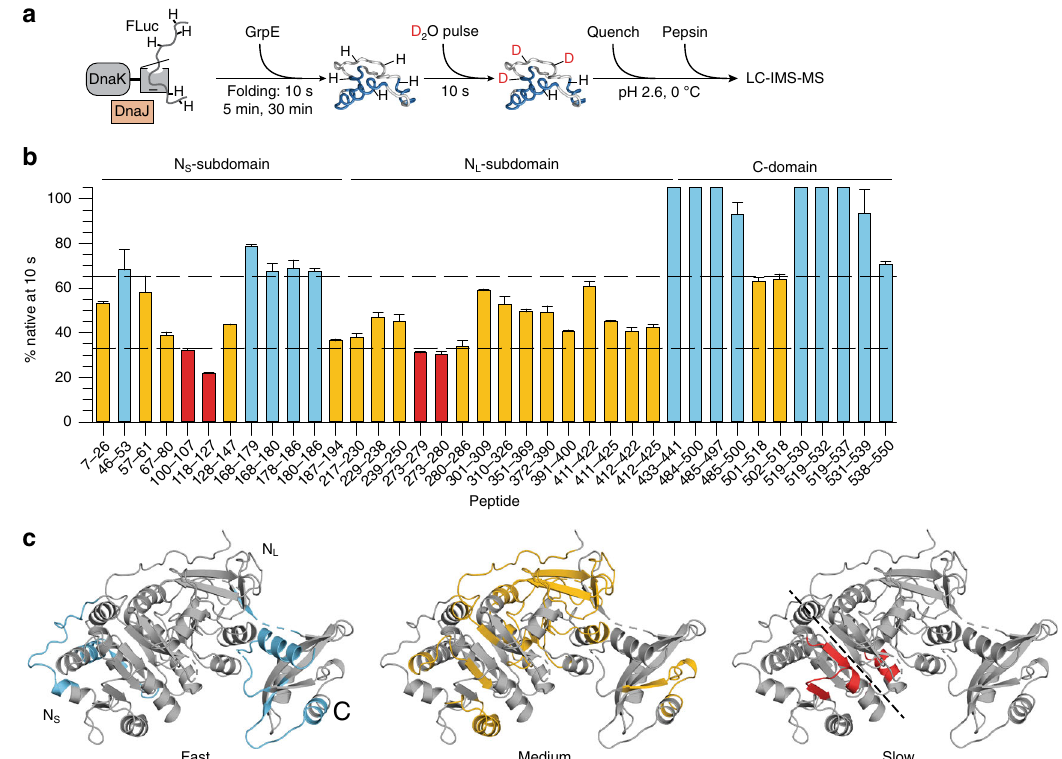
Fig. 6 KJE-assisted folding of FLuc at peptide resolution. a Scheme of H/DX-MS experiment. DnaK is shown schematically in grey and DnaJ in orange. b Fraction of native deuterium exchange reached by FLuc peptides after 10 s folding. D uptake at 10 s was normalized to the difference in D uptake between K-bound and N-FLuc for each peptide. Only peptides exhibiting a >1 Da difference between the DnaK-bound and native states are shown. Peptides are characterized as fast (upper third, blue), medium (middle third, gold) or slow (lower third, red) folders, based on their relative protection compared to N- FLuc. Error bars represent s.d. ( n = 3). Source data are provided as a Source Data fi le. c Location of the peptides colour-coded as in ( b ), indicated on the structure of FLuc. Dotted line indicates the N S – N L domain